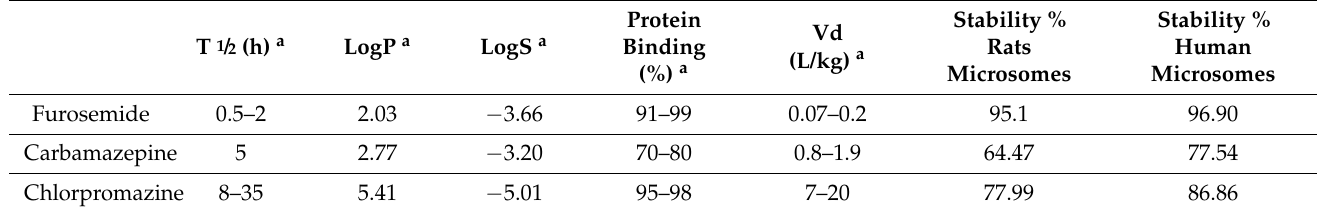
Table 3. PK literature data [30] (a) and in vitro stability data obtained after rat and human liver microsome